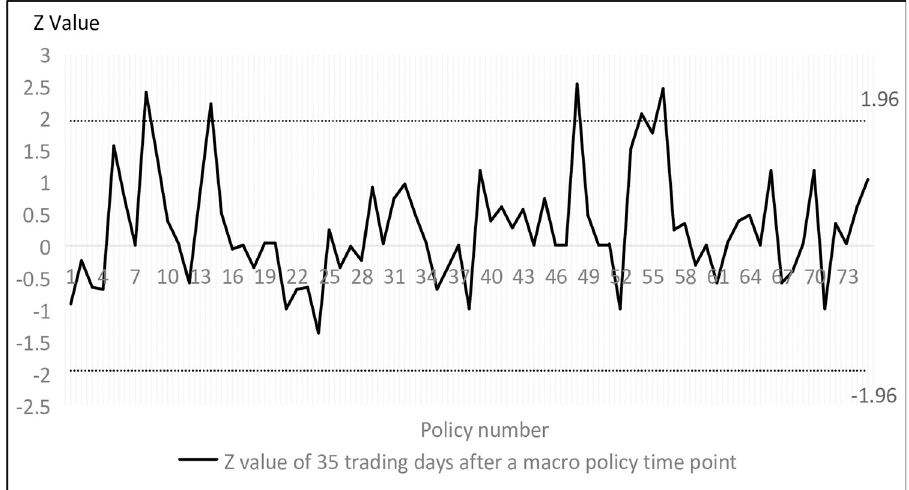
Fig 3. Run test results in 35 trading days after the policy